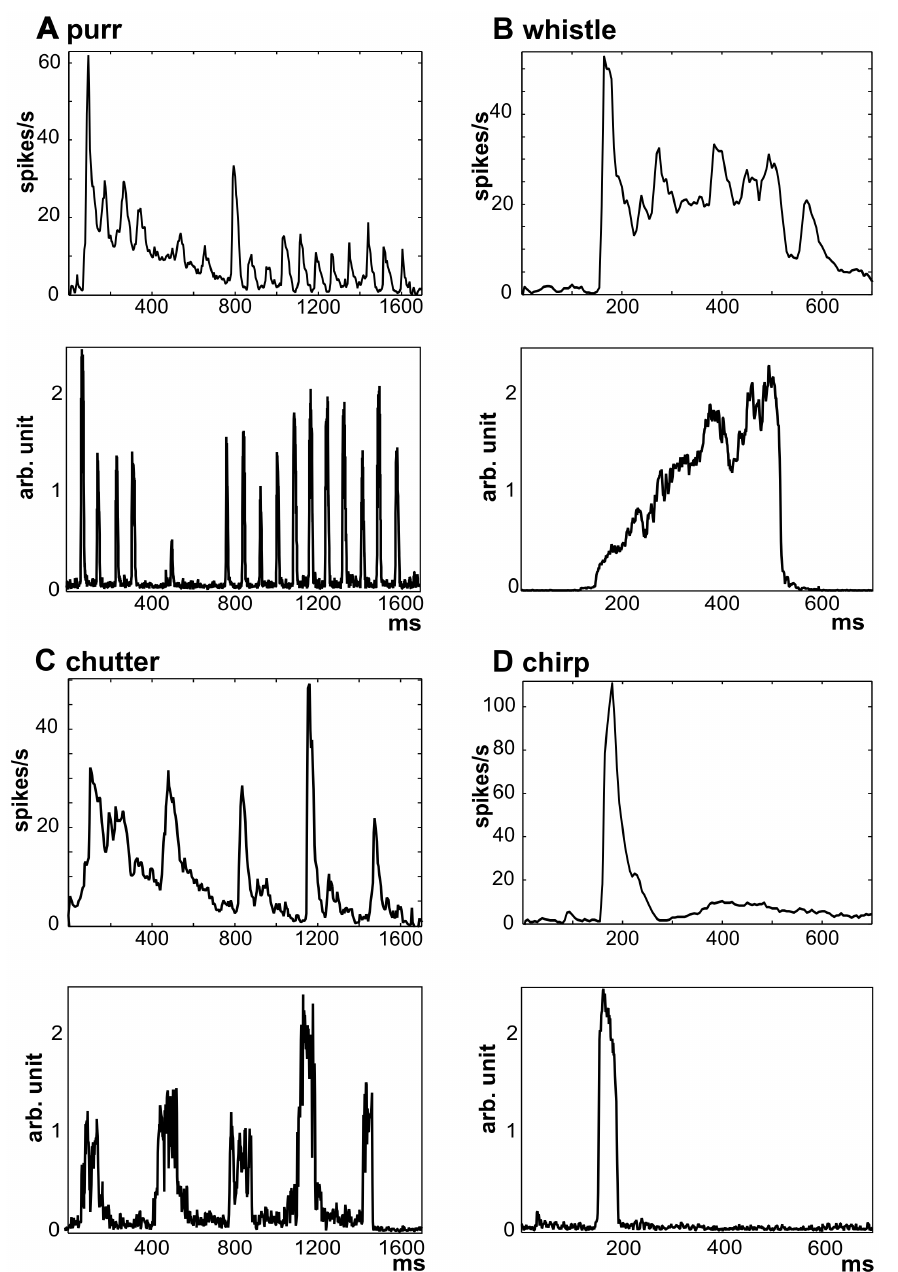
Figure 2. Comparison of the temporal envelope of the calls and the neuronal response. A comparison of the population PSTHs (n=502, top) and the sound envelopes (bottom) is shown for all four calls: purr (A), whistle (B), chutter (C) and chirp (D). Each population PSTH is calculated as the average PSTH of all recorded units. doi:10.1371/journal.pone.0065432.g002 shows the situation for the initial part of whistle (the first 110 ms of the call). The correlation coefficient between the short-term sound spectrum and the appropriate rate-CF profile was 0.48, and the correlation between the ‘corrected’ short-term sound spectrum (the correction reflects the shape of the guinea pig audiogram) and the rate-CF profile was 0.46. The rate-CF profile indicated the dominant spectral component of the fundamental frequency and the 1st harmonic (1–4 kHz), but these two frequencies were not separated. A second peak appeared in the range of 5–7 kHz, and there is also some activity at higher frequencies, even though there